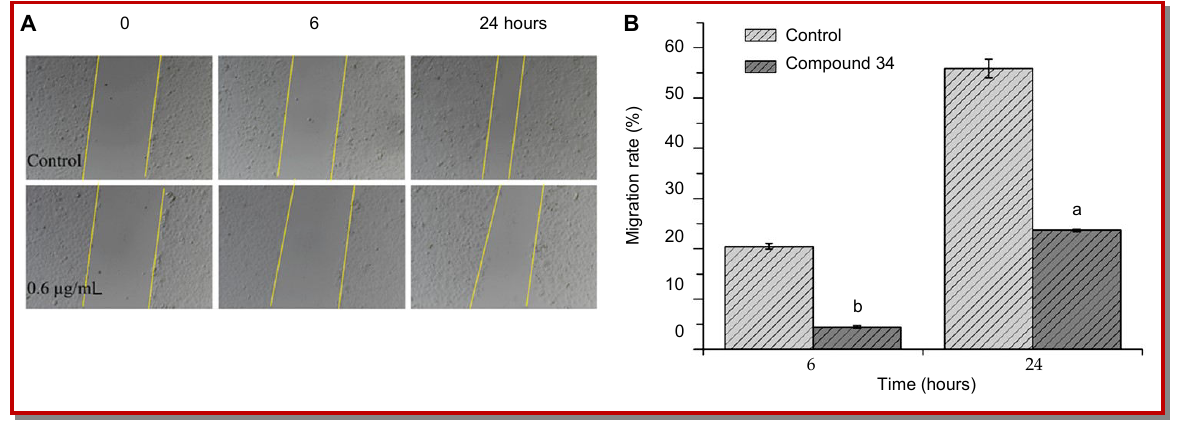
Figure 6: Compound 34 decreased MCF-7 cells migration (A) Images of the wound healing ability of MCF-7 cells treated with compound 34 at 0.6 µg/mL for 6 and 24 hours. (B) Analysis of the wound clo- sure rate of MCF-7 cells by quantitation. Data are presented as the means ± SD, a p<0.05, b p<0.01 as compared with control